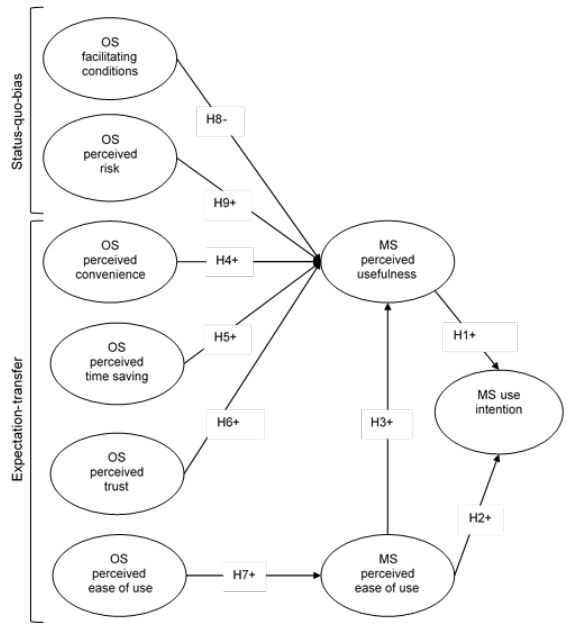
Figure 1: Conceptual